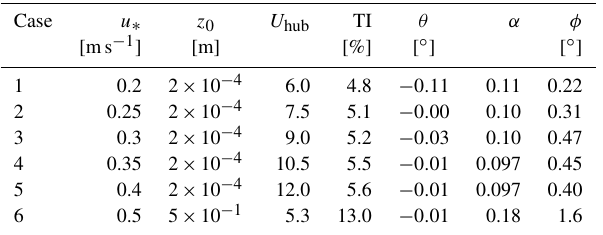
Table A2. Inflow characteristics for each case in flat terrain.